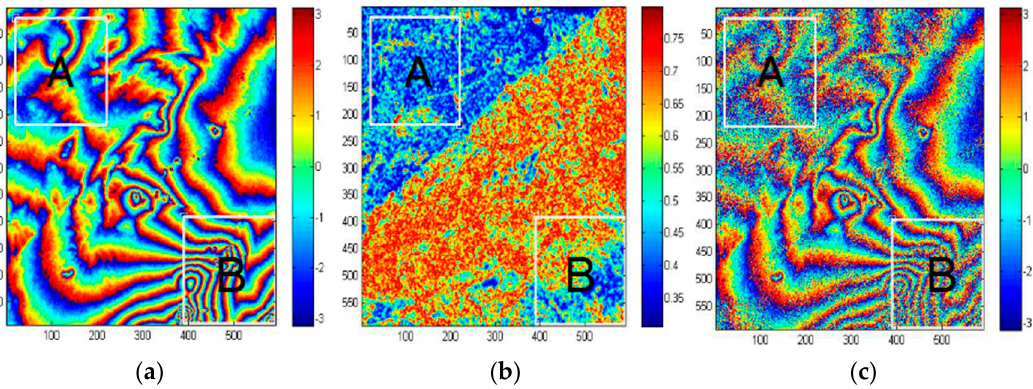
Figure 4. ( a ) Simulated noise-free phase; ( b ) corresponding coherence map; ( c ) simulated noisy phase. A and B, labeled by white rectangles, indicates the enlarged areas.